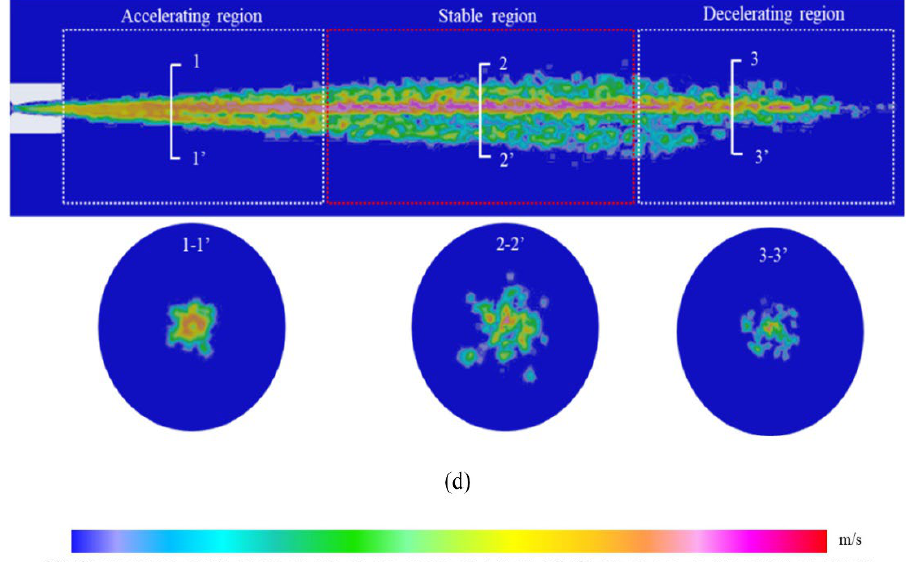
Figure 13. Abrasive particle velocity contour map: ( a ) NPR = 0.6, ( b ) NPR = 1, ( c ) NPR = 1.12 and ( d ) NPR = 2 [129].